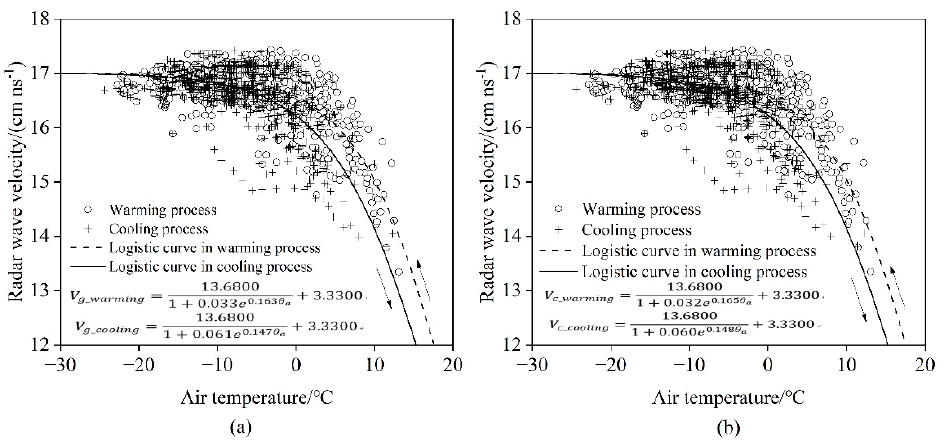
Figure 9. Fitting curves of radar wave velocity in ( a ) granular and ( b ) columnar ice changing with temperature in warming and cooling processes. Table 3. Statistical coefficients and the correlation coefficient of different statistical